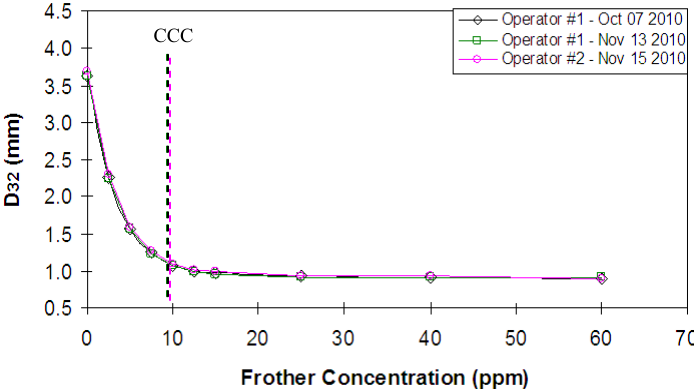
Figure 3. Reliability: Inter-operator and intra-operator replicated experiments at same conditions for DowFroth 250 (DF 250).